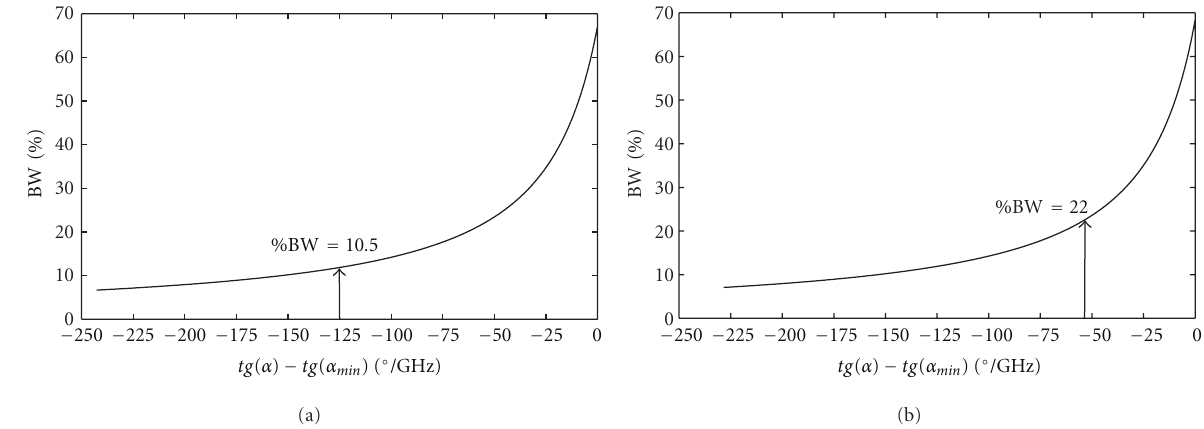
Figure 13: Percent bandwidth estimation ( D = 12 . 4 λ 0 − F/D = 1)—(a) Δ x = Δ y = 0 . 6 λ ; (b) Δ x = Δ y = 0 . 4 λ .